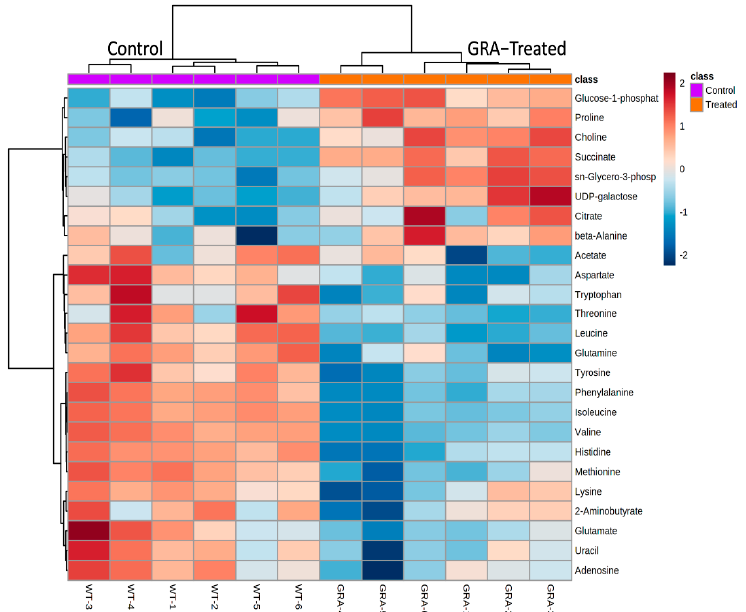
Figure 3. Hierarchical clustering analysis (HCA) and heatmap visualization of intracellular metabolite levels in the GRA-treated (orange) compared to the control (purple) bacterial cultures, with the top 25 metabolites with the most significant level differences that account for the separate clustering of the GRA-treated and untreated bacterial groups. Most notable are the higher levels of glucose-1-phosphate, proline, choline, succinate, sn-glycero-3-phosphocholine, UDP galactose, citrate, and beta-alanine in the GRA-treated cultures, while the levels of most of the other amino acids are higher in the untreated, MRSA control group.